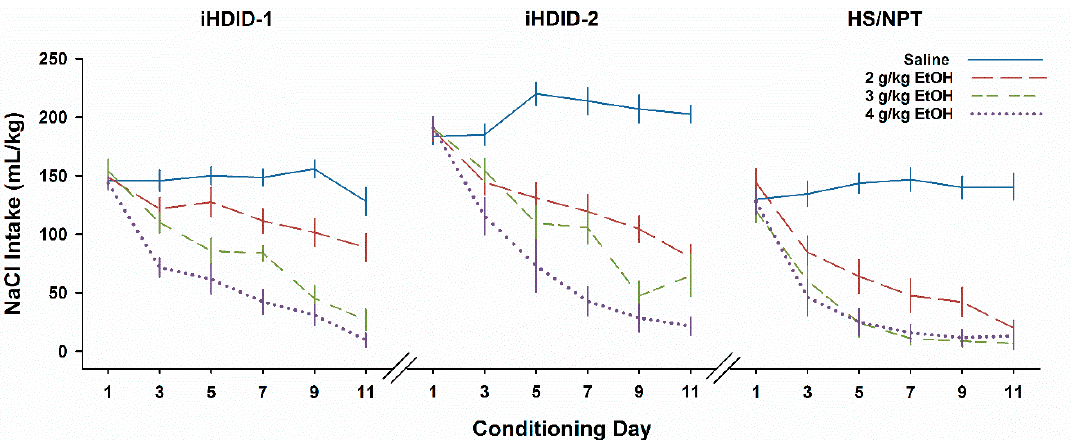
Figure 1. Intake (mL/kg) across days of EtOH taste aversion conditioning varies as a function of genotype and dose. Water intake on even ‐ numbered days is not shown. Mean ± SEM for groups of 12–22 mice per genotype per dose (see Supplemental Figure S1 for sex ‐ specific data).